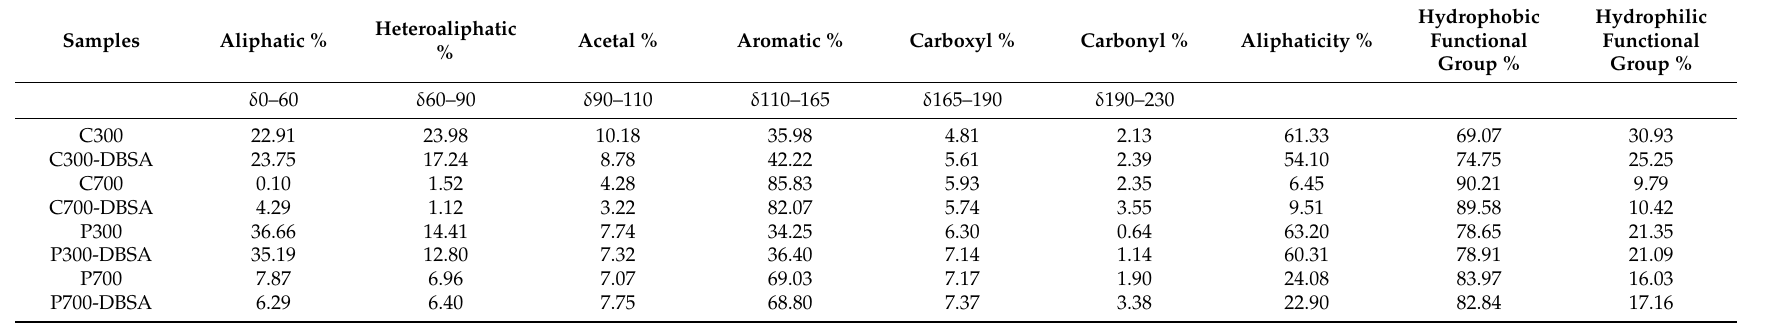
Table 6. Intensity distribution in the 13 C nuclear magnetic resonance (NMR) spectra of